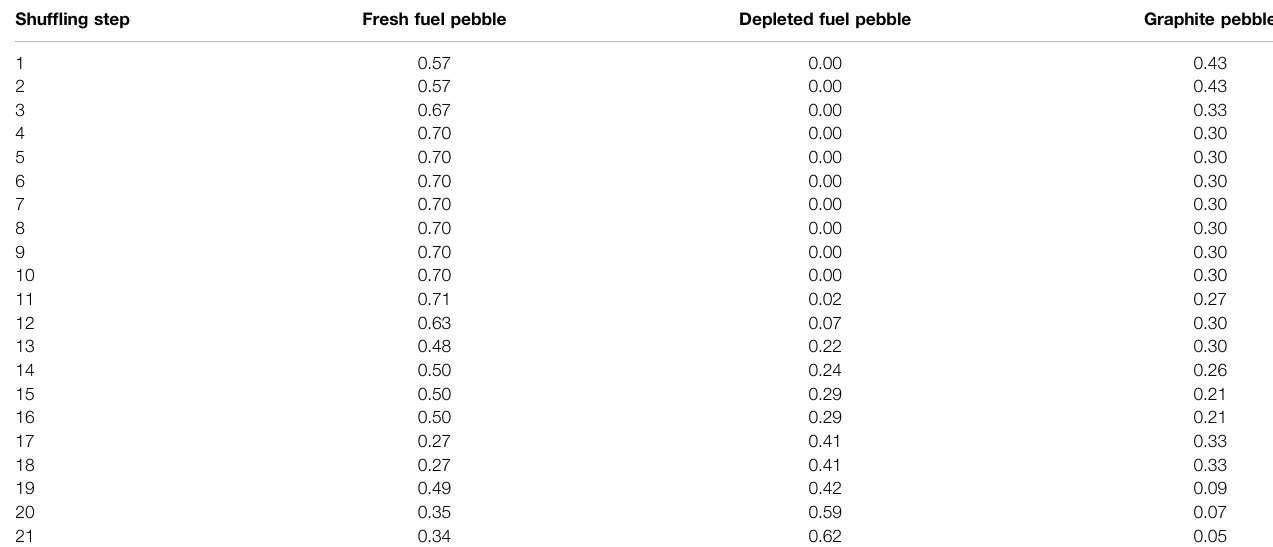
TABLE 3 | Mixing ratio of loaded pebbles in the shuf fl e steps. Shuf fl ing